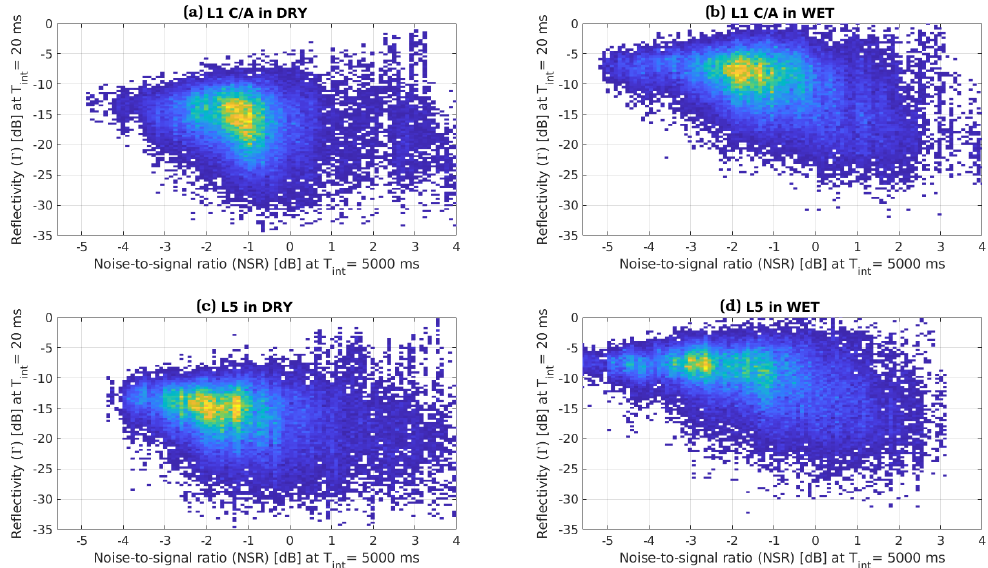
Figure 13. Scatter density plot of the Noise-to-Signal Ratio (NSR) computed at T int = 5000 ms with respect to the reflectivity values at T int = 20 ms at L1 for ( a ) Dry and ( b ) Wet flights, and at L5 for ( c ) Dry and ( d ) Wet